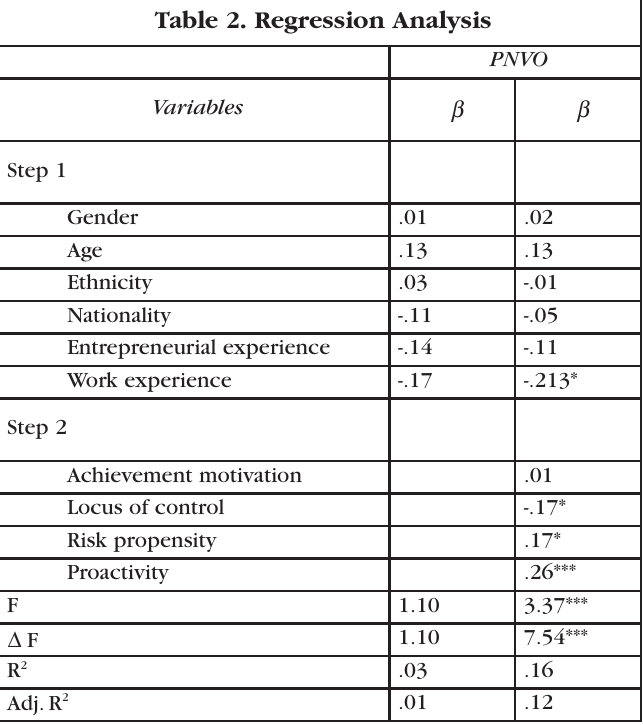
Table 2. Regression